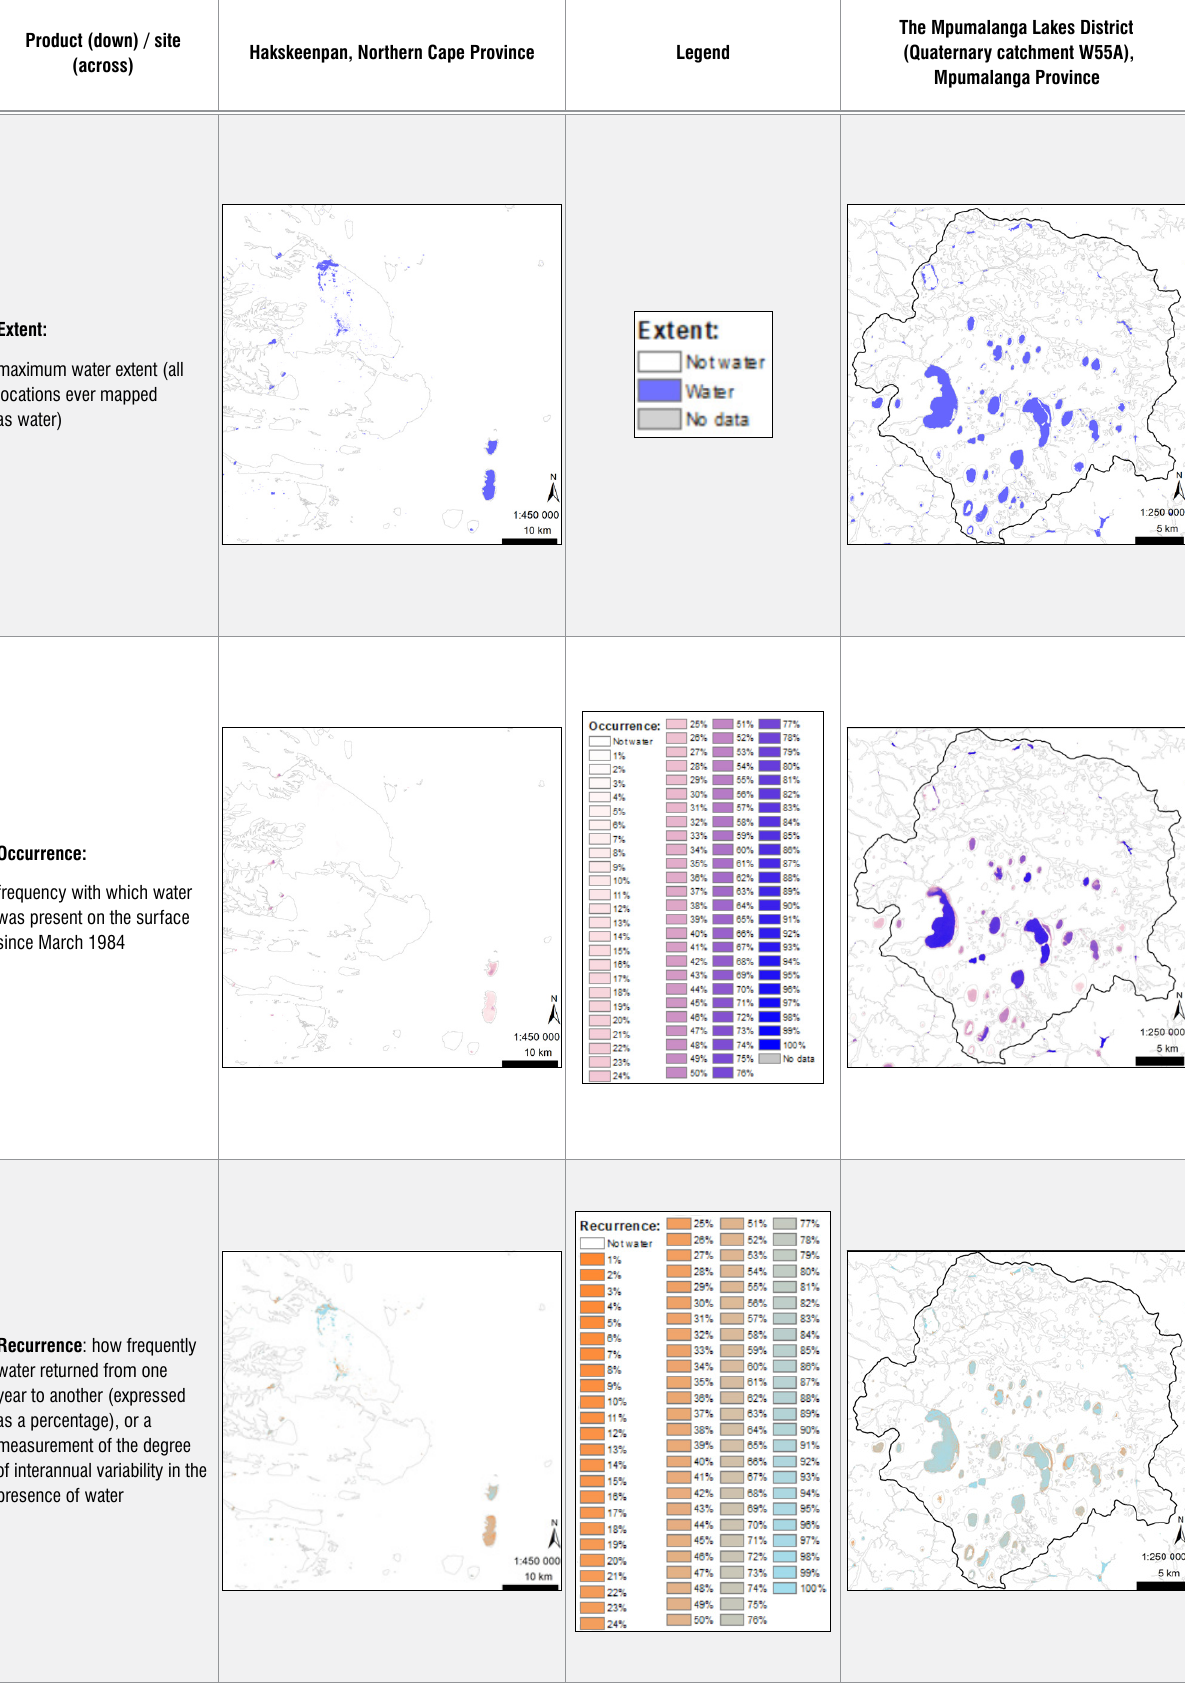
Product (down) / site